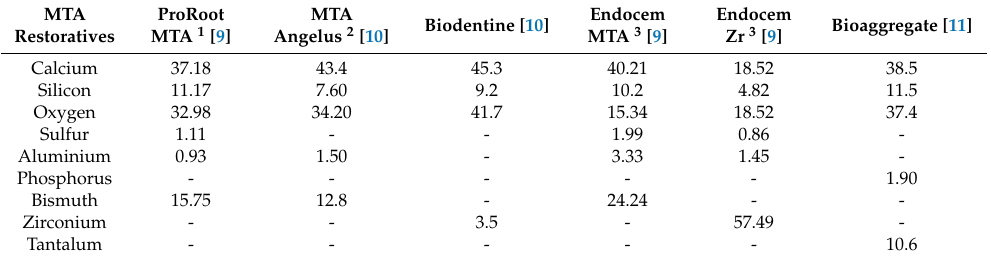
Table 1. Elemental composition comparisons of popular MTA (Mineral trioxide aggregate) restorative brands.